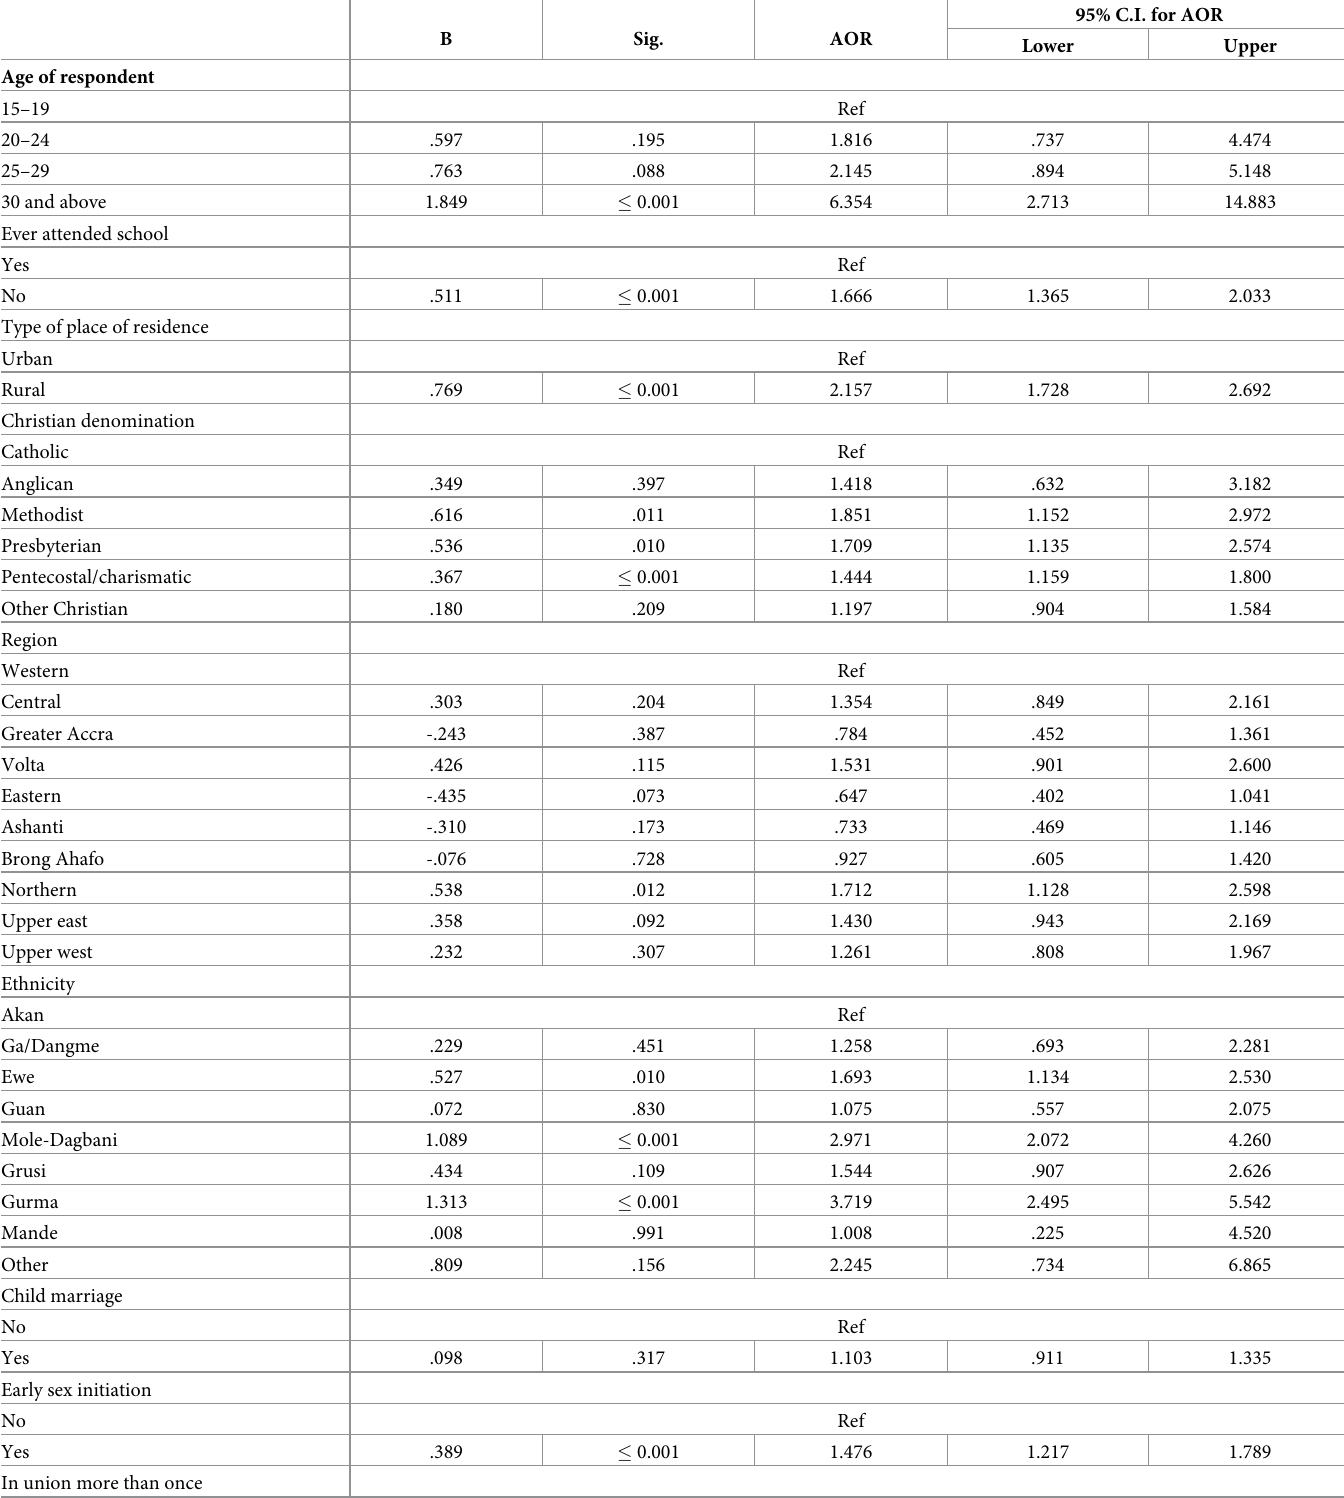
Table 3. Binary logistics analysis of predictor factors of polygyny marriage relations among Christian women of